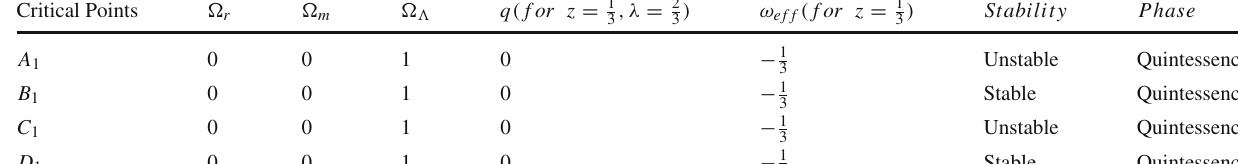
Table 6 Stability conditions, deceleration parameter, density parameters Critical Points